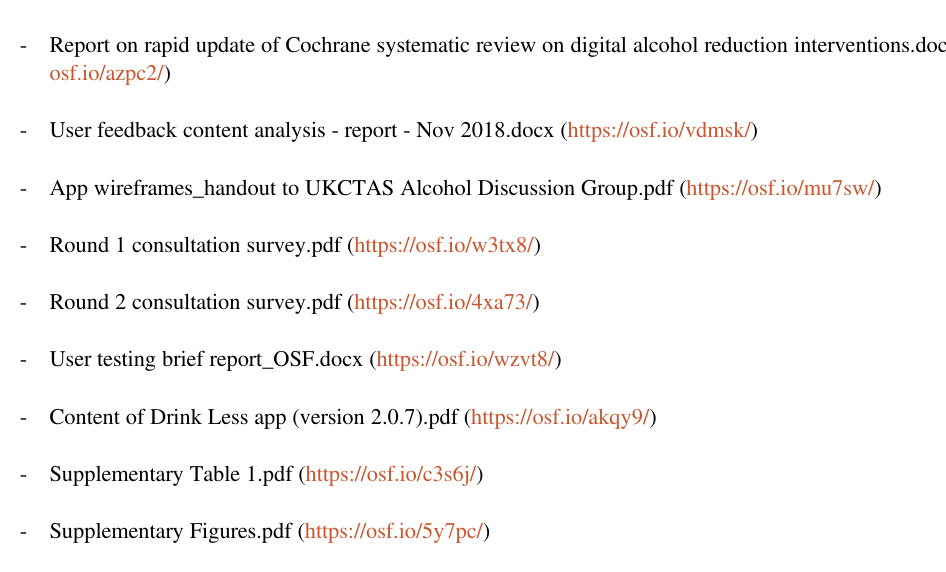
- Supplementary Table 1.pdf (https://osf.io/c3s6j/) - Supplementary Figures.pdf